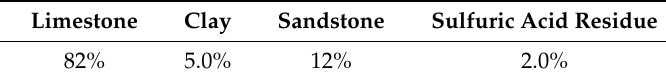
Table 8. The ratio of the four main raw materials. Limestone Clay Sandstone Sulfuric Acid